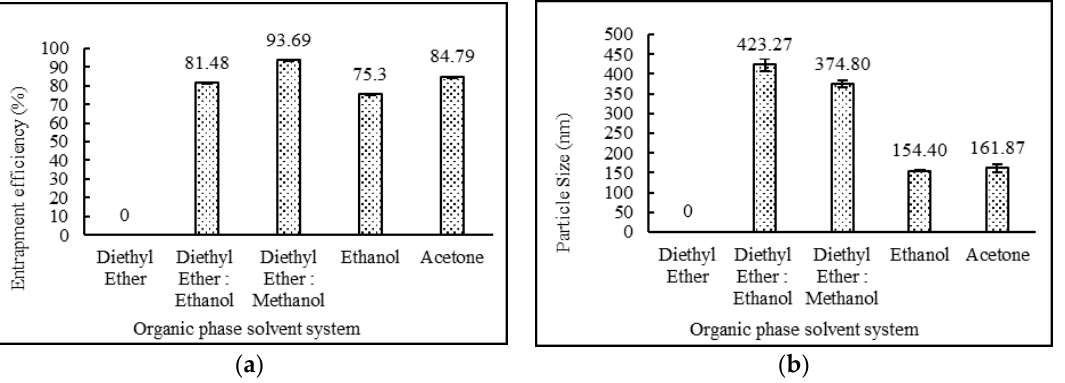
Figure 1. Effect of organic phase system on ( a ) entrapment efficiency (%) and ( b ) particle size (nm) of Figure 1. E ff ect of organic phase system on ( a ) entrapment e ffi ciency (%) and ( b ) particle size (nm) of niosomes. ( N = 3, mean ± SD). niosomes. ( N = 3, mean ±